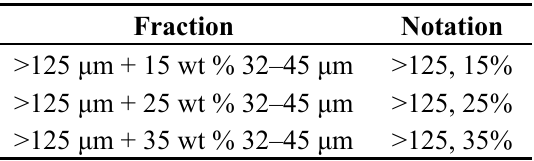
Table 2. Bimodal